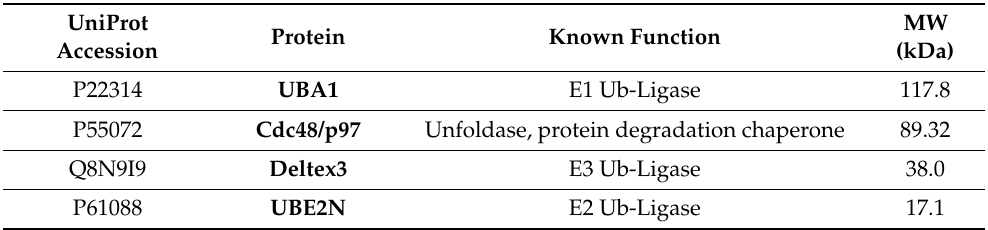
Figure 1. Identification of selective autocrine IGF-II-dependent intracellular EphB4 binders via immuno-affinity proteomics. ( a ) Immune-enriched proteomic experimental workflow; ( b ) heat map of proteins detected by Ms/Ms in EphB4 immune-precipitates upon ex vivo deprivation of the autocrine IGF-II signal; ( c ) Panther TM analysis of the proteins identified by immune-enriched proteomics. Table 1. IGF-II-regulated Ubiquitin-related components identified in EphB4 immune complex in MSTO211H cell lysates by Ms/Ms.